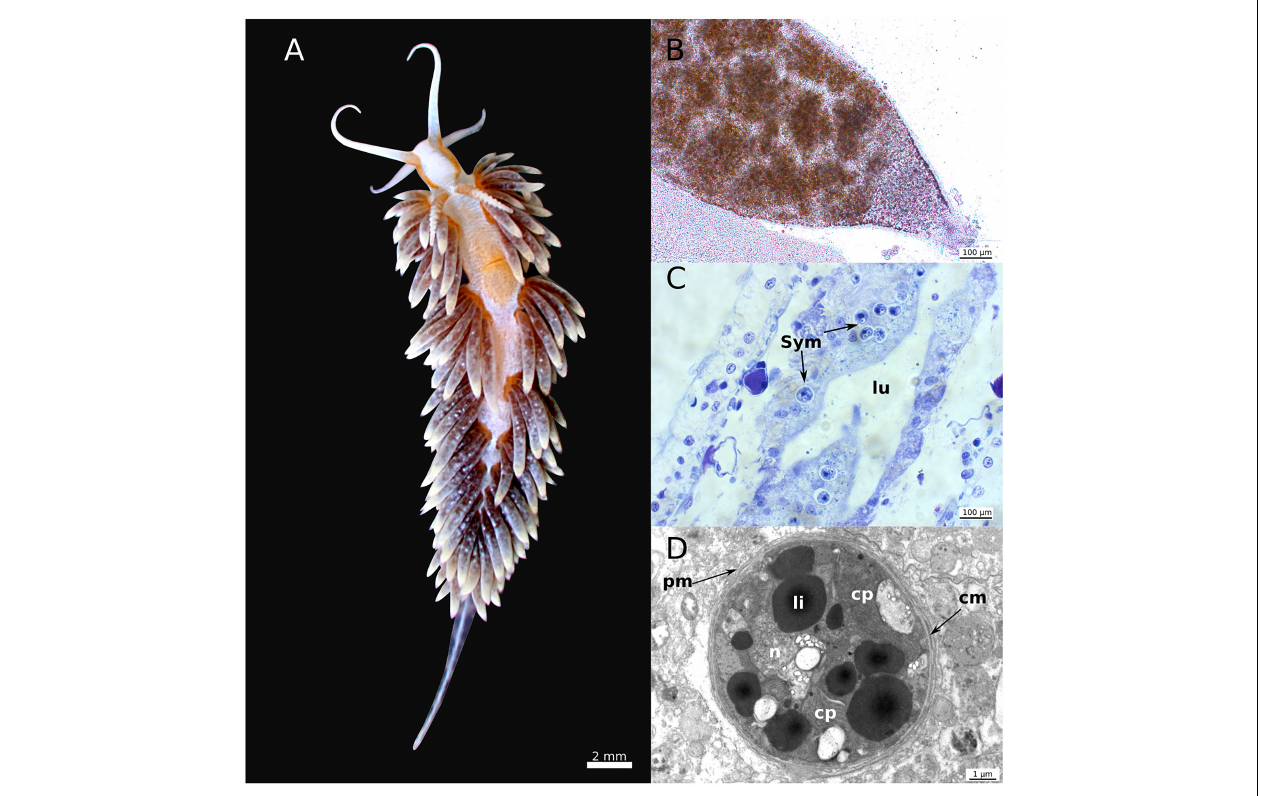
FIGURE 2 | Morphology and microscopic details of Berghia stephanieae . Morphology of B. stephanieae (A) . Detail of a cerata of B. stephanieae bearing the photobionts (B) , histological cross-section through a cerata showing the host cells of the cerata bearing the photobiont (C) , and detail of the coccoid (non-motile) stage of intracellular Symbiodiniaceae (D) . cm: Symbiodiniaceae cell membrane, cp: chloroplast, li: lipid droplets, lu: lumen of the host digestive gland, n: nucleus, pm: host phagosomal membrane, Sym: Symbiodiniaceae. The images were taken by Gregor Christa (A,B) , Jenny Melo (C) and Elise Laetz (D)